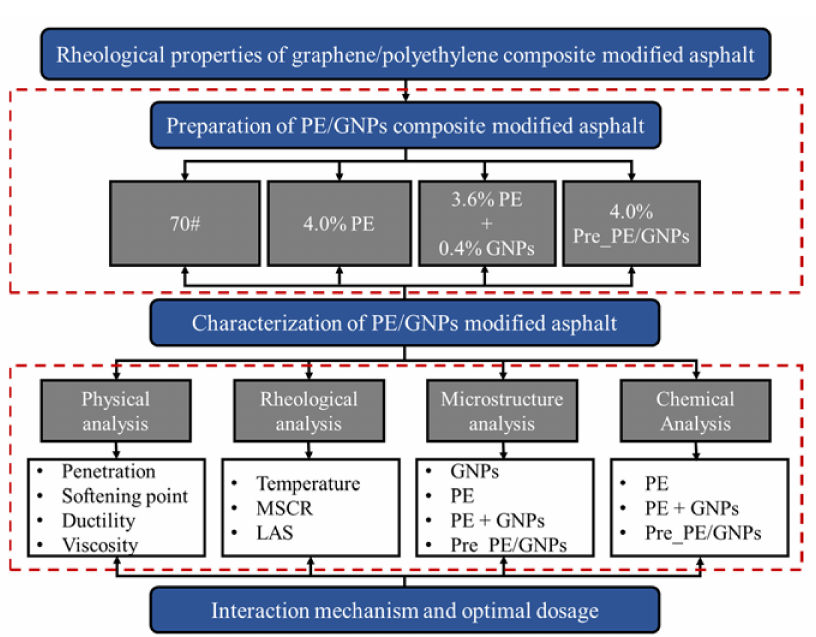
Figure 1. Schematic flow chart of research procedure.